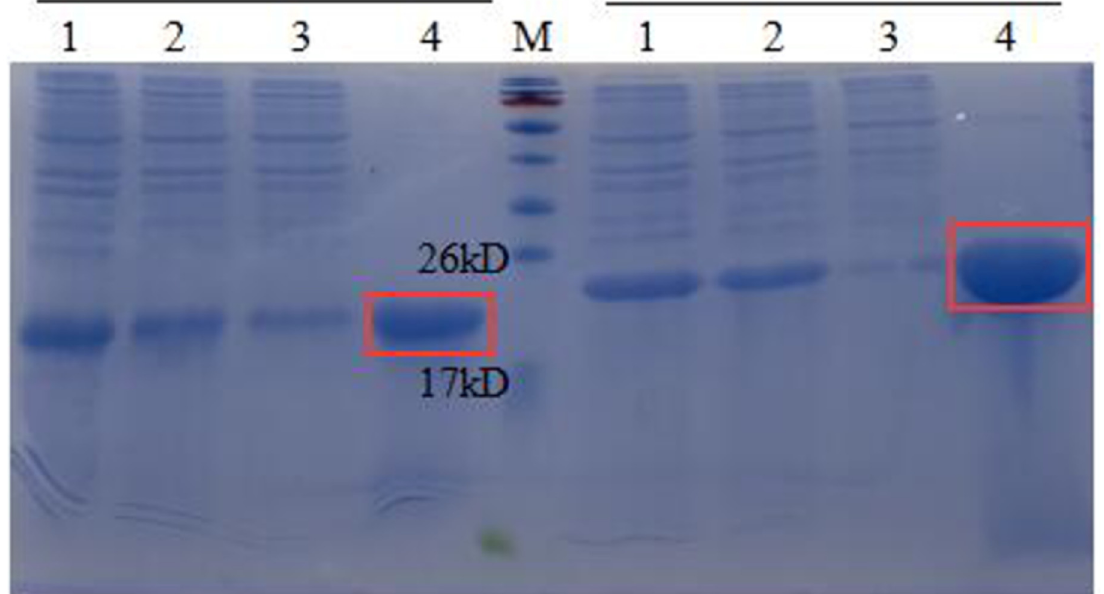
Figure 4. SDS-PAGE (12%) analysis of AMP (13, 16) purification. M, protein molecular weight marker. Left, lane 1, the supernatant of EAP 13; lane 2, the supernatant of EAP 13 heated to 80 °C for 30 min; lane 3, the flow-through of EAP 13 with Ni2+-affinity; lane 4, the AMP 13 purified with Ni2+-affinity. Right, lane 1, the supernatant of EAP 16; lane 2, the supernatant of EAP 16 heated to 80 °C for 30 min; lane 3, the flow-through of EAP 16 with Ni2+-affinity; lane 4, the AMP 16 purified with Ni2+-affinity.